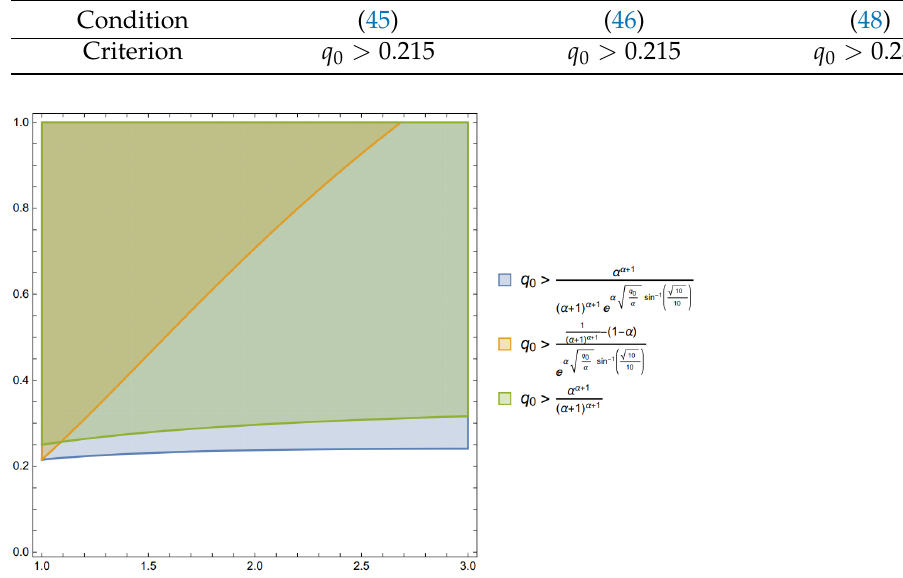
Figure 1. Regions for which conditions (45)–(47) are